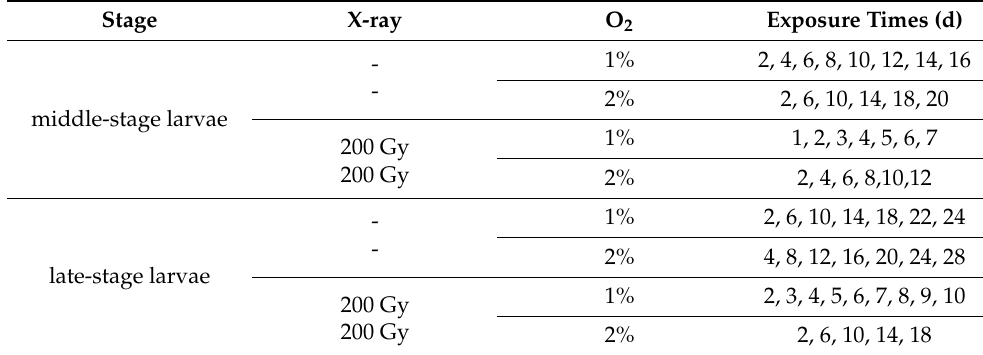
Table 1. Exposure times for the dose-response tests on T. granarium larvae at 24–26 °C. Stage X-ray O 2 Exposure Times (d)